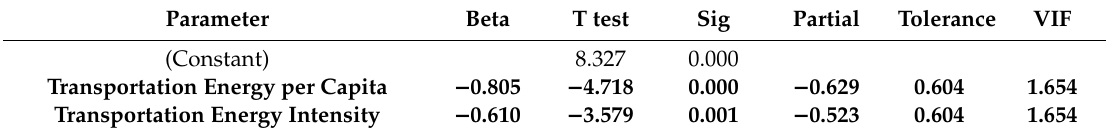
Table 17. Multicollinearity and partial correlation of parameters from the Transportation Sector